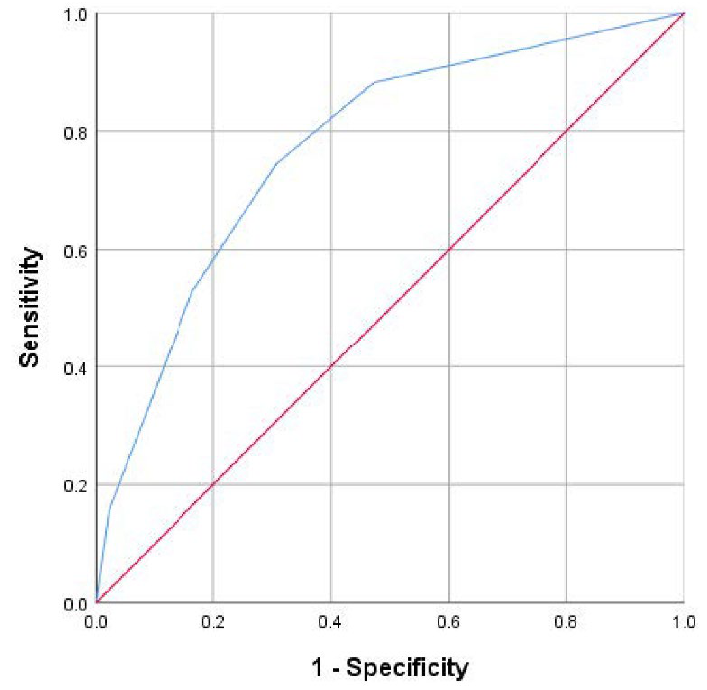
Figure 1. ROC curve of prognostic score (0 to 4 points) for recurrence at 24 months. At 36 months, 95%, 83%, 73%, 60%, and 19% of the patients with scores 0, 1, 2, 3, and 4 were recurrence-free, respectively. The median TTR was not reached in patients with scores 0 −3 . Patients with score 4 had a median TTR of 29 months (95% confidence interval (CI): 0.1 to 60.23). Significant differences were observed between the groups ( p < 0.001), see Figure 2. Patients were divided into a low-risk group (score = 0; n = 138; 45% of the patients) and a high-risk group (score = 1 −4 ; n = 166; 55% of the patients). At 36 months, 95% and 67% of the patients in the low-risk and high-risk groups were recurrence-free, respectively. Patients assigned to the low-risk group had a significantly longer TTR than patients assigned to the high-risk group. The median TTR was not reached in either group, with a HR for disease recurrence of 0.13 (95%CI: 0.05 to 0.31; p <0.001), see Figure 3.